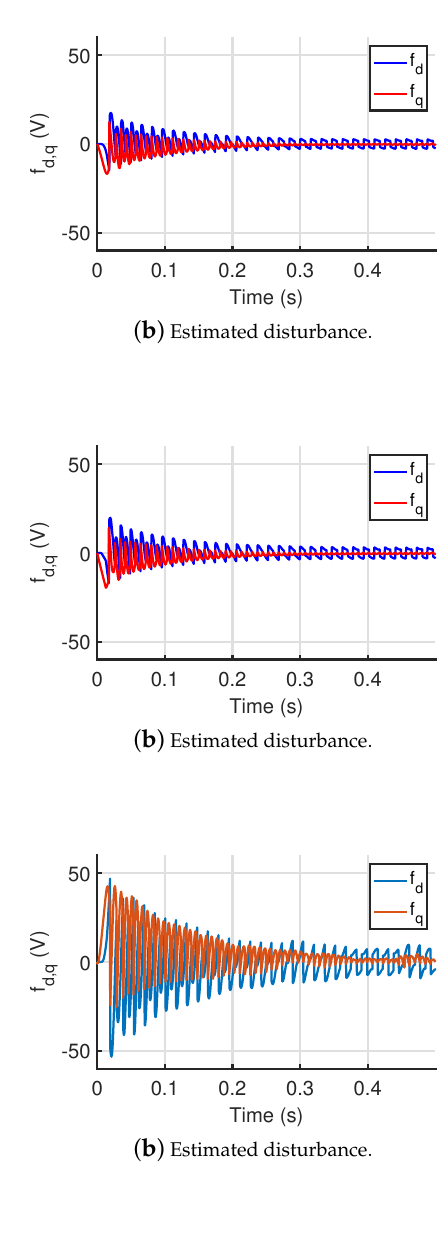
Figure 4. Simulation results of the proposed observer with stepped load.